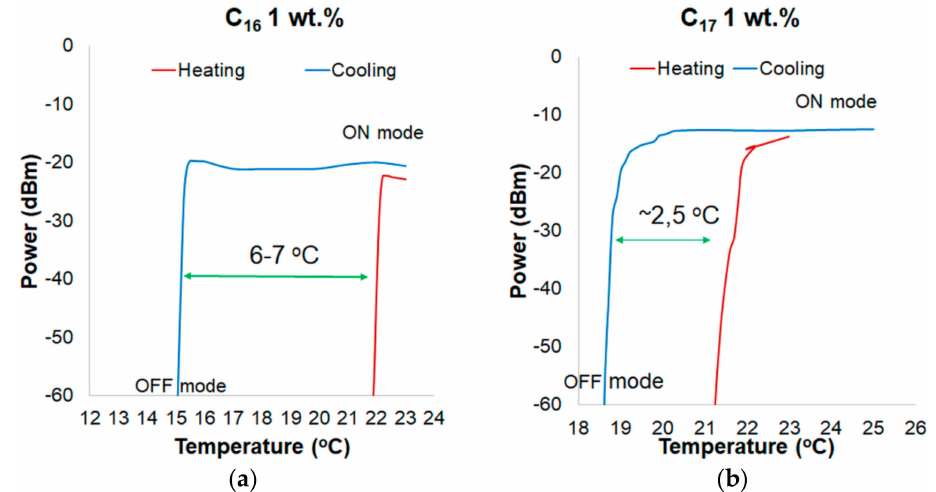
Figure 8. Hysteresis of power changing for a wavelength of 810 nm for: ( a ) pure C 16 and ( b ) pure C 17 .